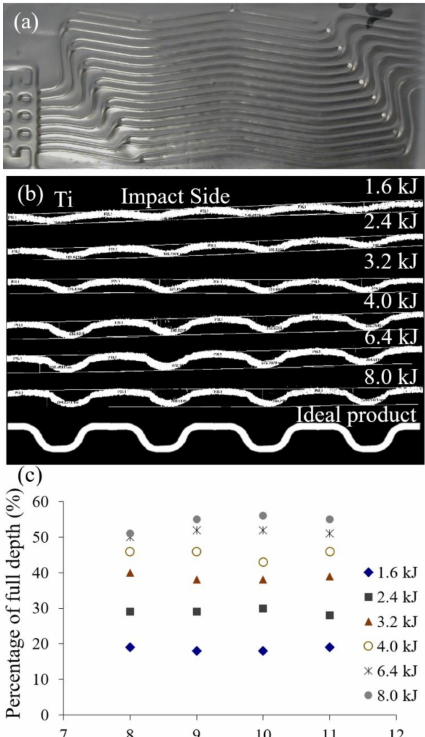
Figure 8. ( a ) The deformed Ti sheet with magnetic pulse forming; ( b ) the cross-sectional profile of the deformed Ti sheet at capacitor bank energies of 1.6 kJ, 2.4 kJ, 3.2 kJ, 4.0 kJ, 6.4 kJ, and 8.0 kJ; and ( c ) the channel depth of the deformed Ti sheet at capacitor bank energies of 1.6 kJ, 2.4 kJ, 3.2 kJ, 4.0 kJ, 6.4 kJ, and 8.0